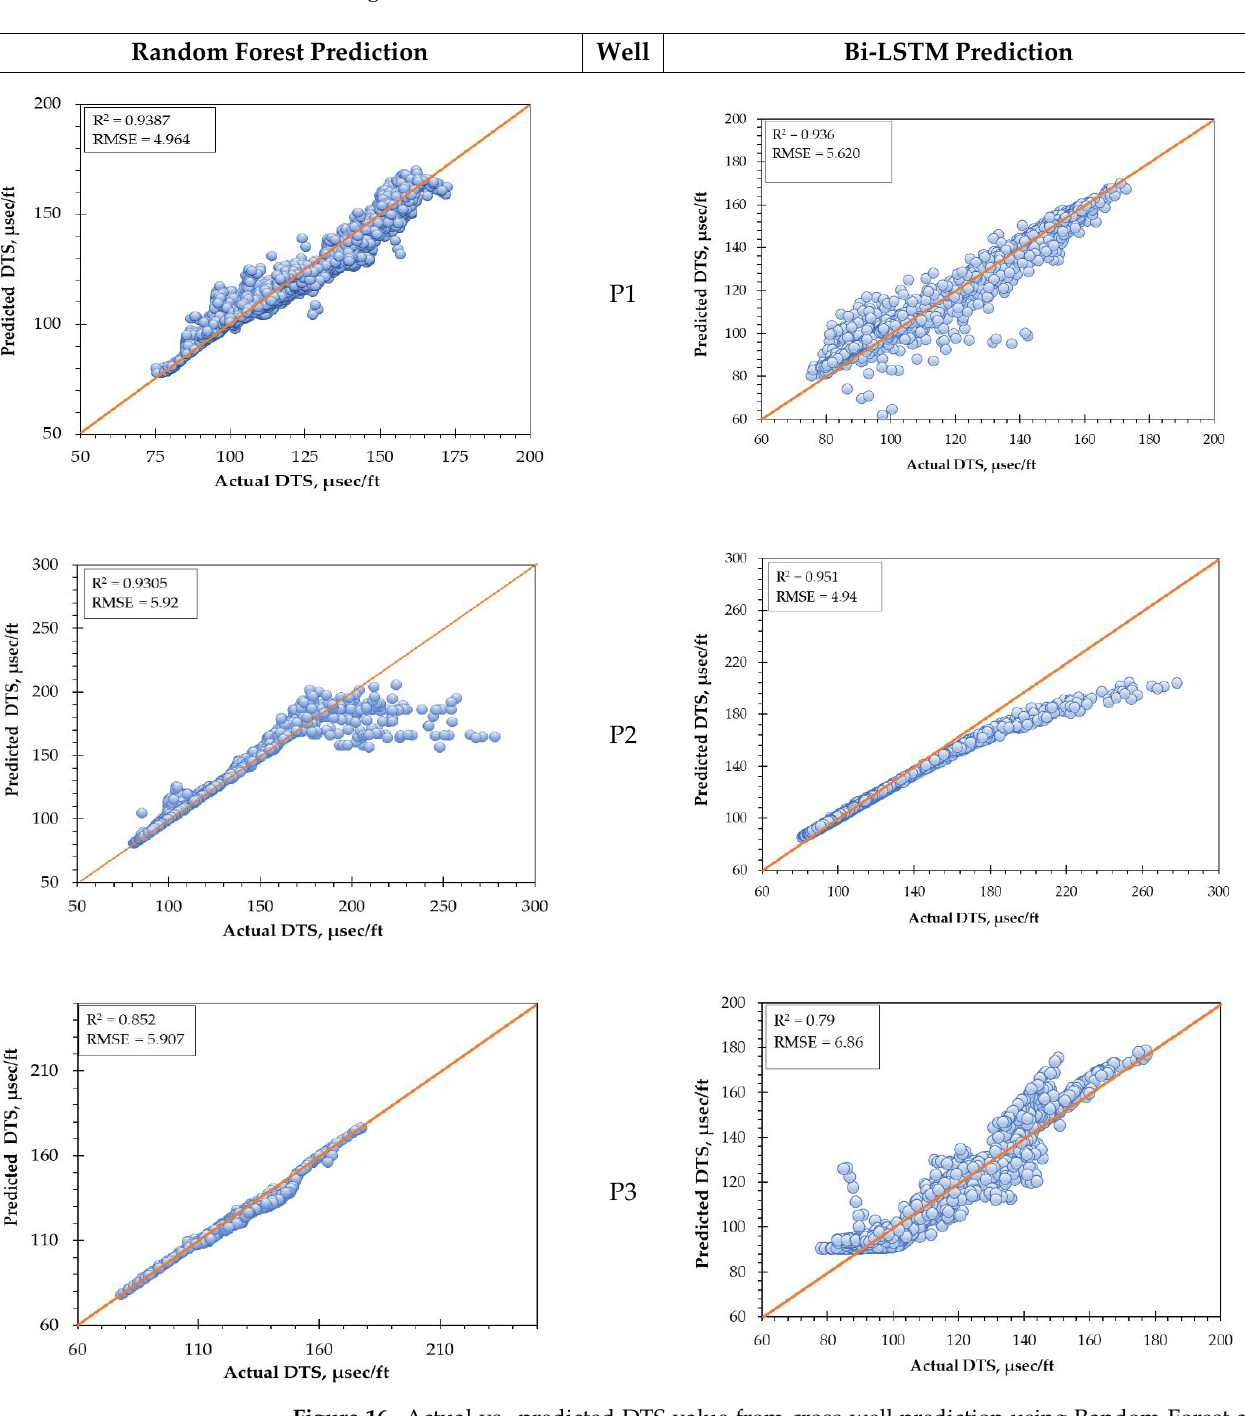
Figure 16. Actual vs. predicted DTS value from cross-well prediction using Random Forest and Bi- LSTM.